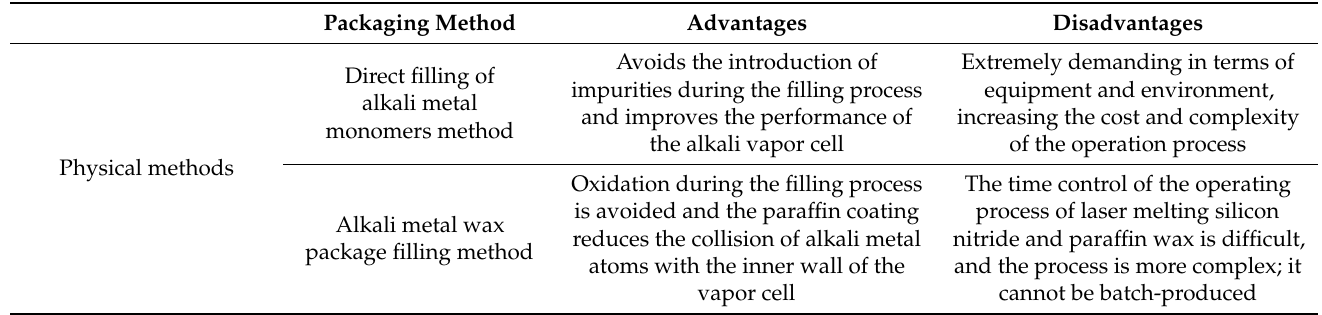
Table 1. Comparison of the advantages and disadvantages of different encapsulation methods for alkali